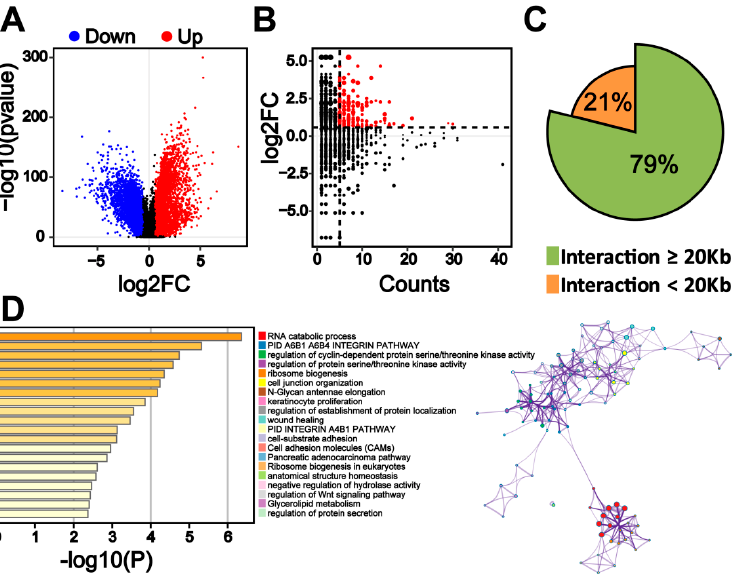
Figure 5. Transcriptome change in colorectal cancer cells is associated with colorectal-specific enhancers. ( A ) Volcano plot depicting gene expression changes in normal colon tissue ( n = 349) and colorectal cancer tissue ( n = 275). ( B ) Comparison of fold changes in gene expression based on RNA-seq and HiChIP signals. The plot shows 735 target genes. Red dots indicate target genes that were found to significantly change (fold change > 1.5; q < 0.01) in colorectal cancer tissue com- pared to those of normal colon tissue and have significant HiChIP signals (counts ≥ 5). ( C ) Percentage of long-range (>20 kb) interaction loops between colorectal-cancer-specific enhancers and target genes. ( D ) Functions of genes as analyzed by